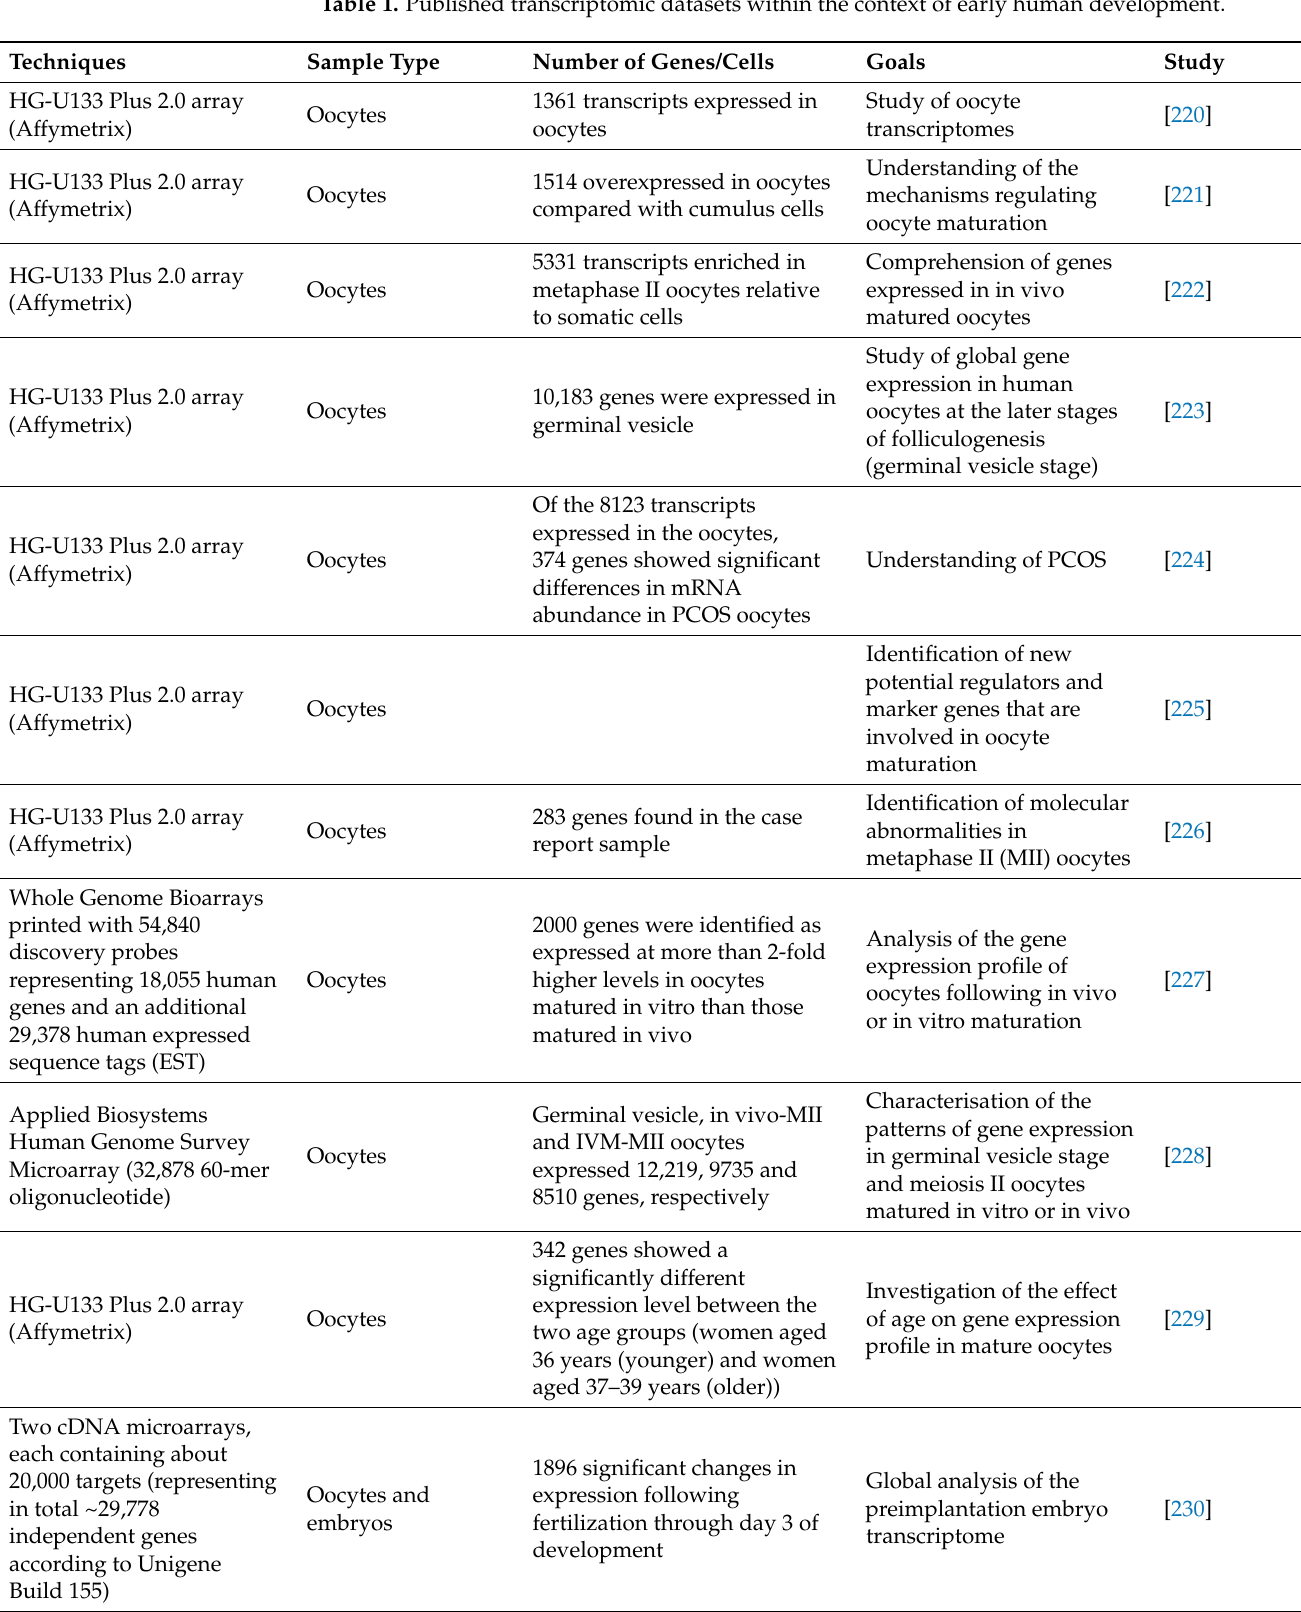
Table 1. Published transcriptomic datasets within the context of early human